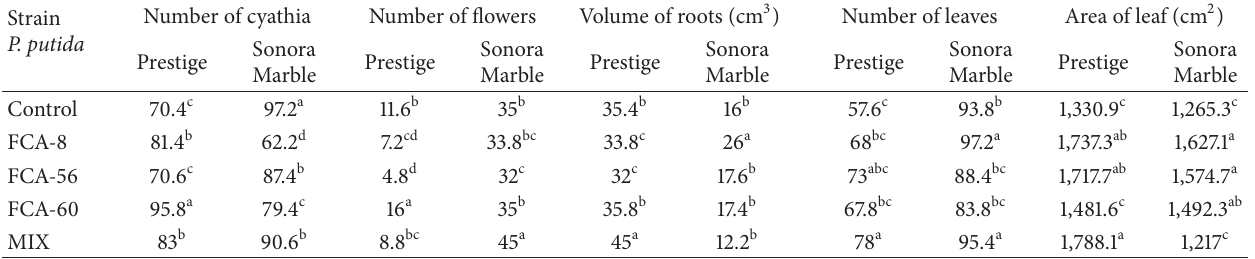
Table 1: Effects of Pseudomonas putida strains on growth promotion of poinsettia Prestige and Sonora Marble cultivars. Number of cyathia Number of flowers Volume of roots (cm 3 ) Number of leaves Area of leaf (cm 2 ) Strain P. putida Sonora Sonora Sonora Sonora Sonora Prestige Prestige Prestige Prestige Prestige Marble Marble Marble Marble Marble Control 70.4 c FCA-8